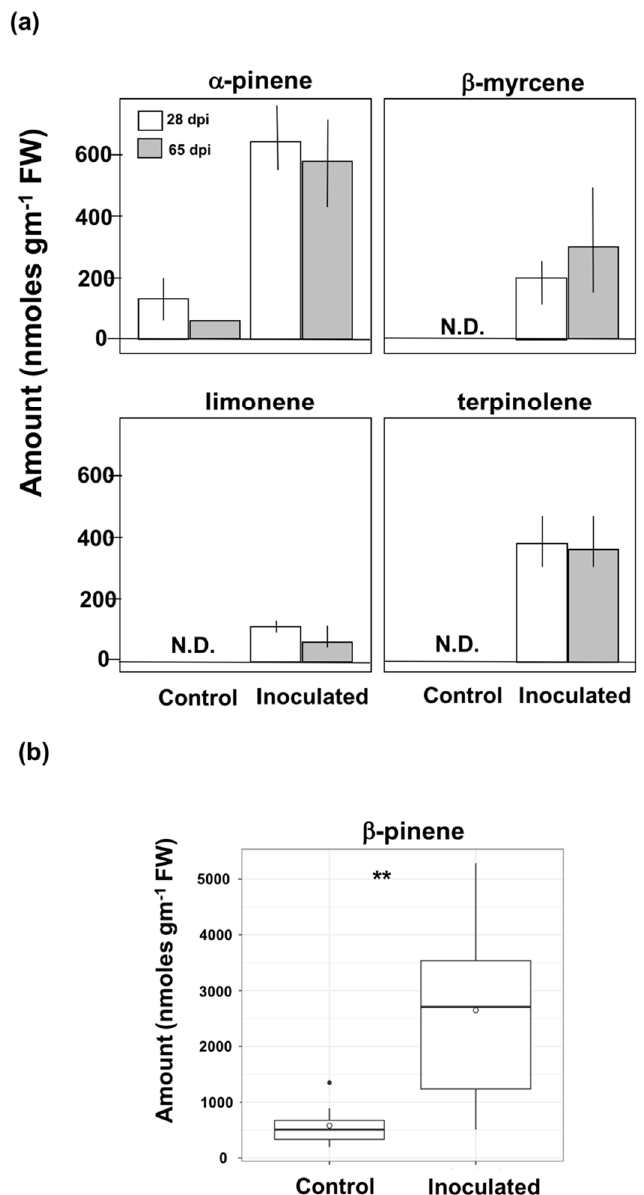
Figure 7. O. minus induced changes in phloem terpenoids of eastern white pine. ( a ) Individual monoterpene amount (nmol gm − 1 FW) (Mean ± SE, n = 3–10). ( b ) β -pinene amount (nmol gm − 1 FW) ( n = 8–12) and is significantly increased due to fungal attack (** p ≤ 0.01); boxes show median, 1st and 3rd quartiles, and whiskers indicate 1.5 interquartile range.